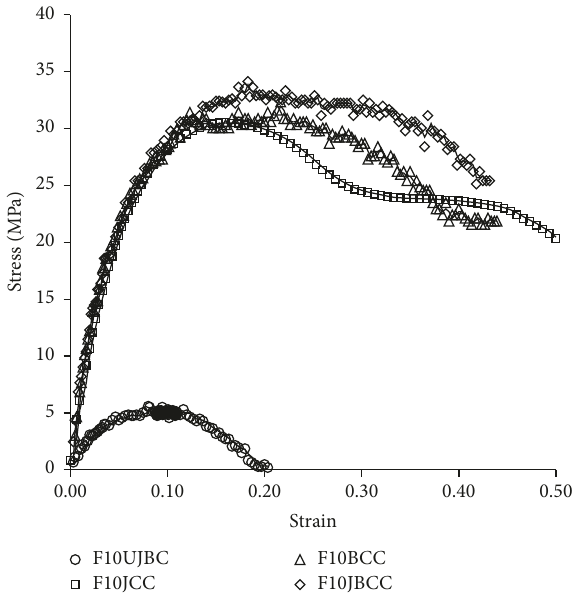
Figure 7: Stress-strain graph of hybrid composite at 10wt% fiber